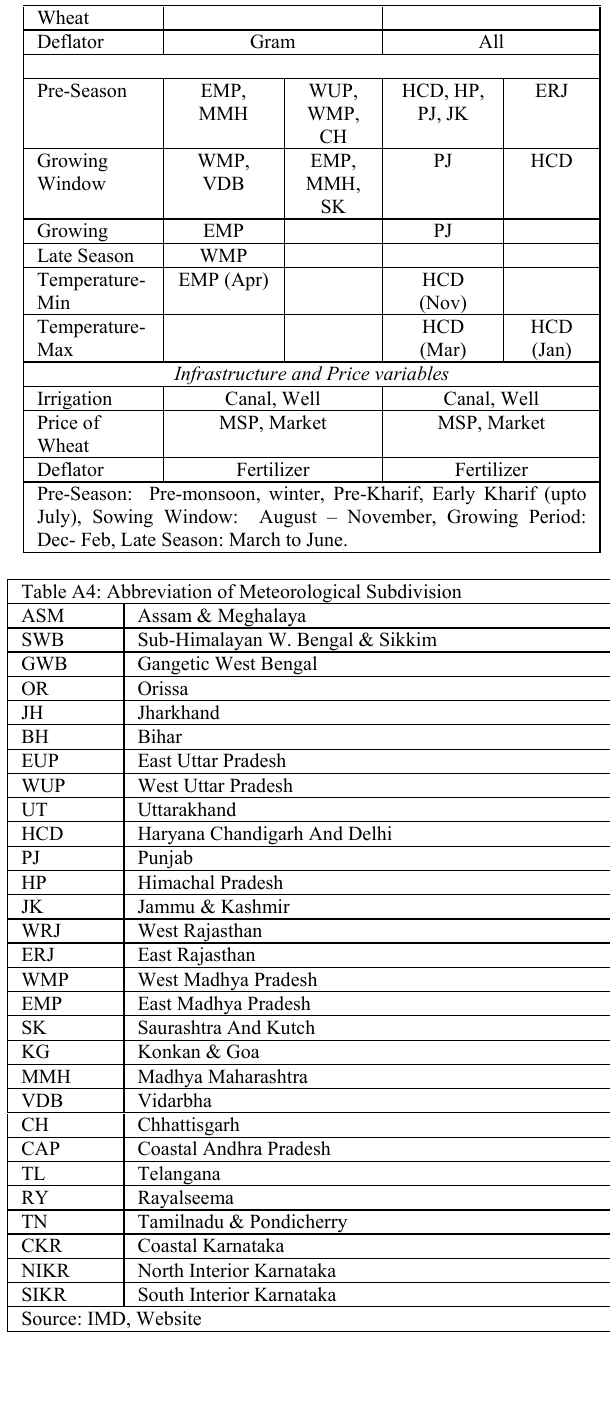
Table A3b: Variables that matter based on estimated regression equation: Wheat Rabi Madhya Pradesh